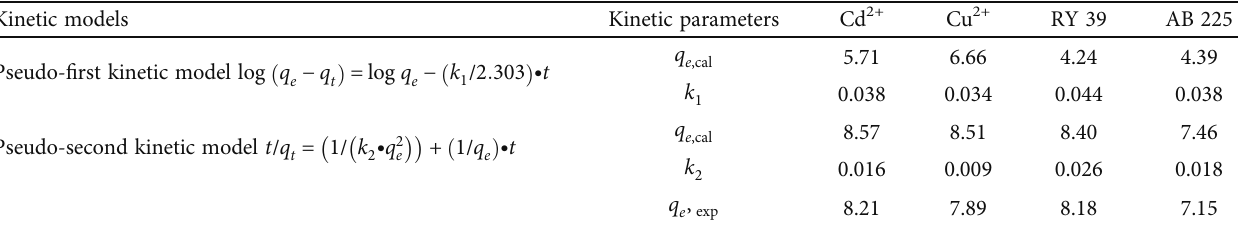
Figure 8: (a) Adsorption kinetic data and linear fi t with (b) pseudo- fi rst and (c) pseudo-second-order kinetic. Table 3: Kinetic models ’ equations and kinetic parameters obtained by the pseudo- fi rst- and pseudo-second-order kinetic models for metal ions and dye adsorption onto